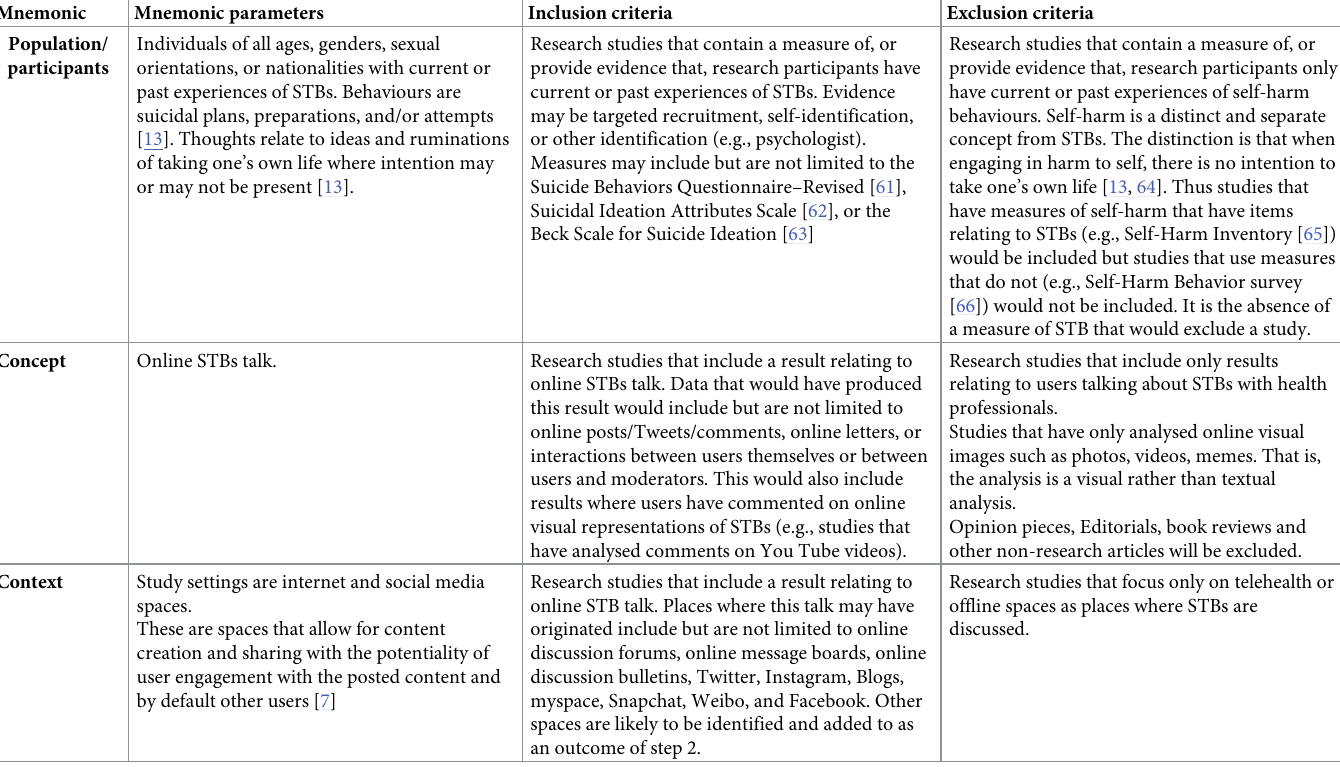
Table 1. Population/Participant–Concept–Context parameters with inclusion and exclusion